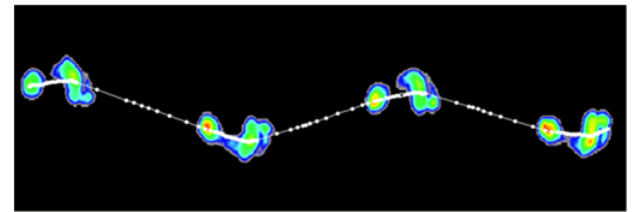
Figure 1. Roll ‐ off screen (Footscan ® platform system). Figure 1. Roll-off screen (Footscan ® platform system).